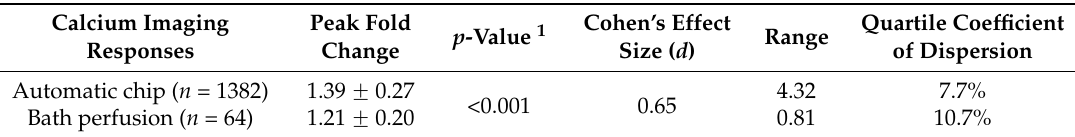
Table 1. Comparison of calcium responses of NCI-H716 cells to 1 mM glucose stimulation in the automatic chip and bath perfusion experiments.